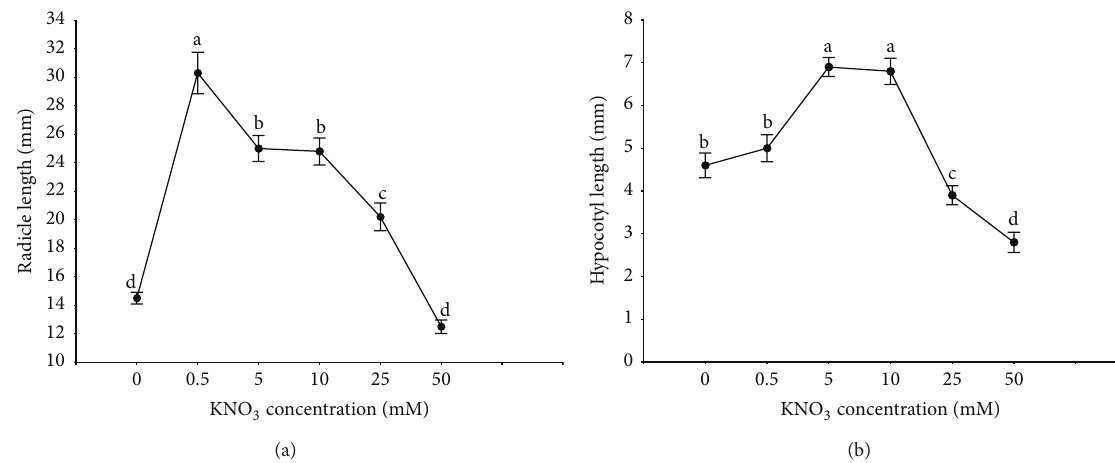
Figure 7: Effect of KNO 3 concentration on the radicle (a) and hypocotyl lengths (b) of R. confertus . Means ( 𝑛 = 4 ) with the same letter do not differ ( 𝑃 > 0.05 ). Error bars indicating standard